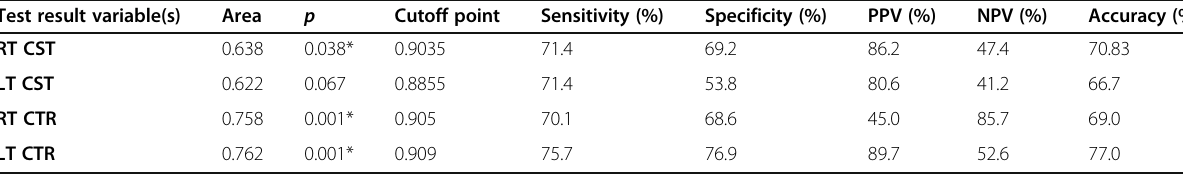
Table 5 The overall sensitivity, specificity, PPV, NPV, and AUC of MD values in CP and control group in CST and CTR Test result